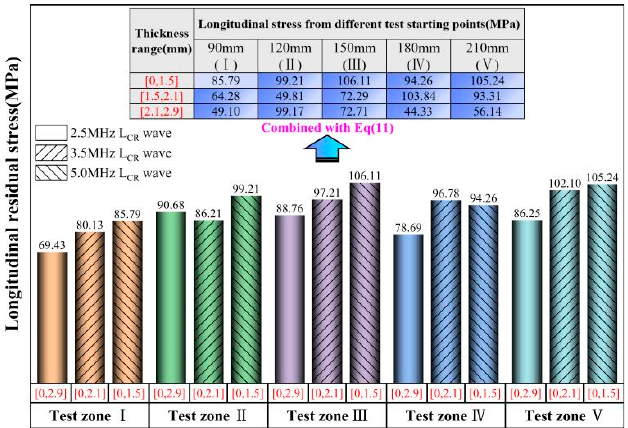
Figure 13. Ultrasonic testing of residual stresses in different thickness layers of WZ.